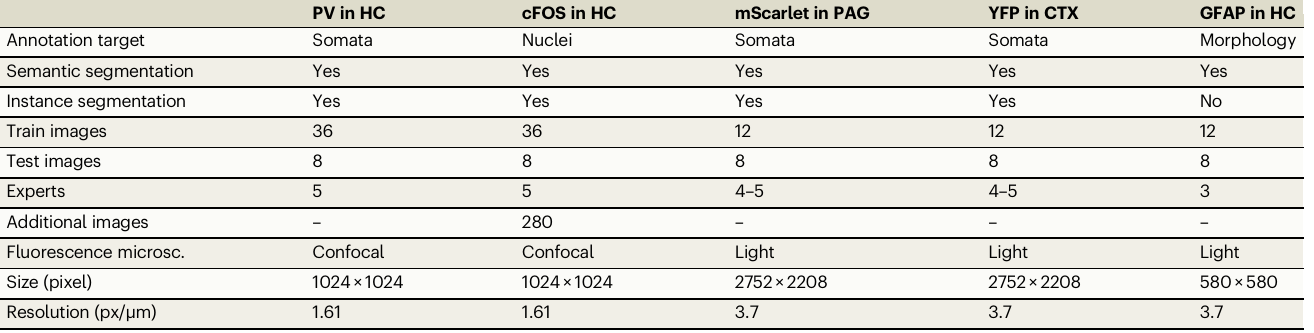
Table 1 | Comparison of immuno fl uorescence